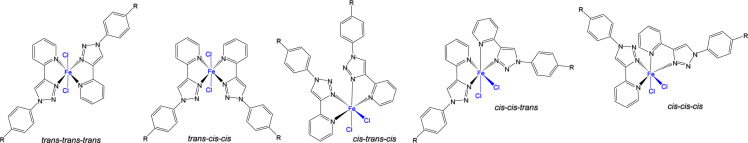
Structure and isomers of Dichloro(bis{2-[1-(4-R-phenyl)-1H-1,2,3-triazol-4-yl-κN3]pyridine-κN})iron(II) coordination compounds [Fe(Ln)2Cl2] with R=CH3 (L2), OCH3 (L3), COOH (L4), F (L5), Cl (L6), CN (L7), H (L8) and CF3 (L9) [2]. The isomers are defined by the relative positions of (i) Cl, (ii) Npyridyl and (iii) Ntriazole around Fe.